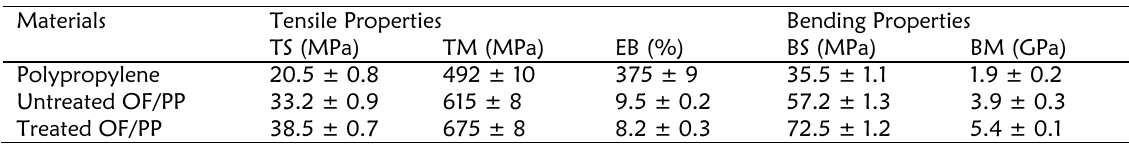
Table 1: Comparative tensile and bending properties of unreinforced PP sheet and the optimized composites (45% fiber content) found in this study